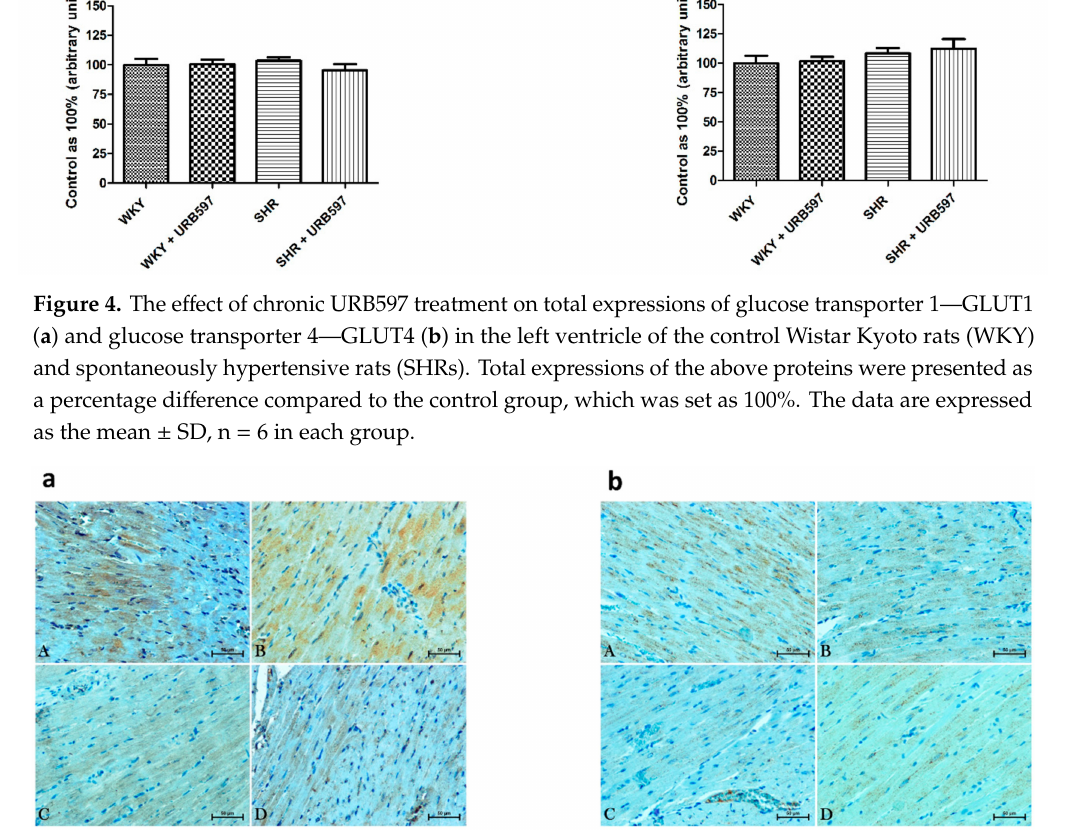
Figure5. Representativeimagesofglucosetransporter1—GLUT1( a )andglucosetransporter4—GLUT4 ( b ) expressions in the left ventricular cardiomyocytes in the control Wistar Kyoto rats (WKY) and spontaneously hypertensive rats (SHRs), where ( A ) is WKY group, ( B ) WKY + URB597 group, ( C ) is SHR group and ( D ) SHR +